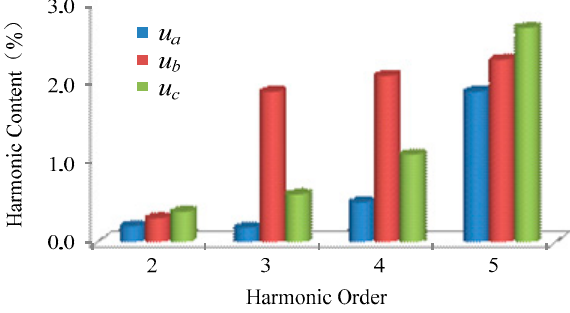
Figure 5. Frequency analysis of the converter bus voltage.